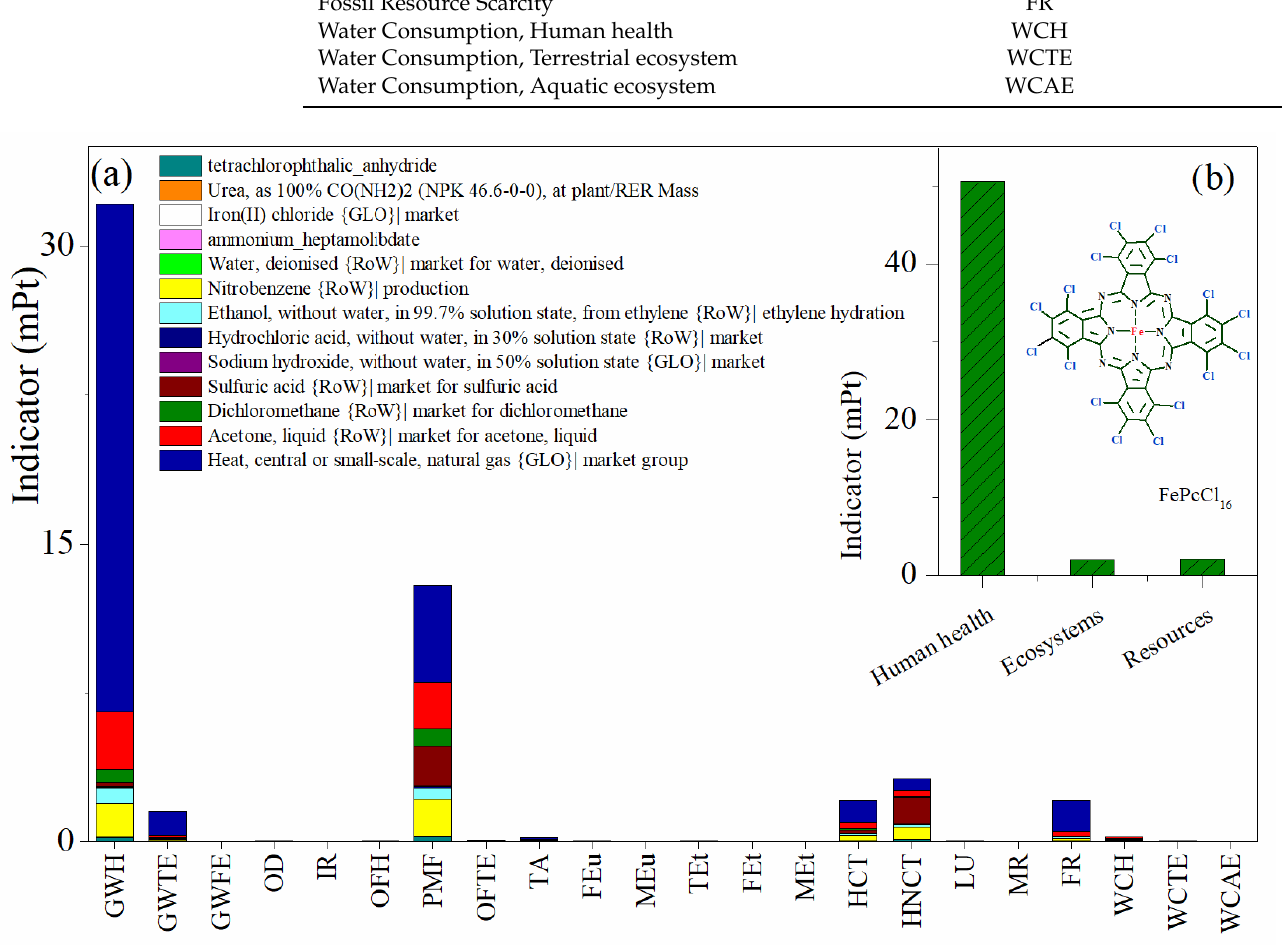
Figure 5. Environmental impact assessment by weighting indicators in the production of FePcCl 16